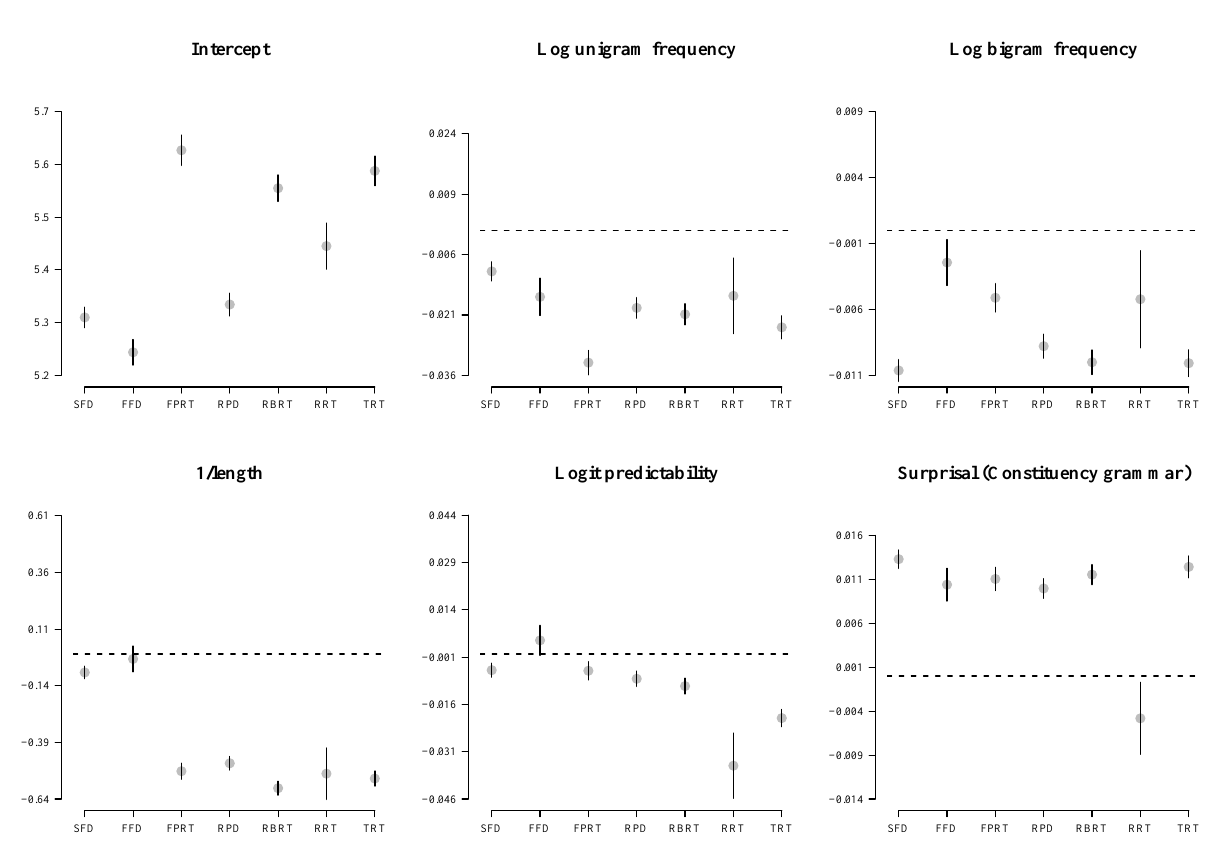
Figure 5 . Regression coefficients and 95% confidence intervals for the multiple regression, using as predictors unigram and bigram frequency, 1/length, logit predictability and phrase-structure based